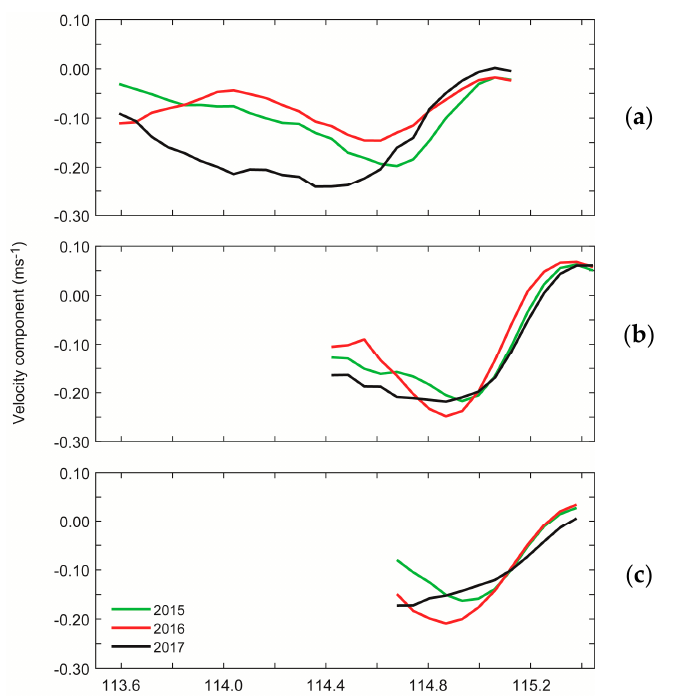
Figure 8. Mean cross-shelf profiles of HFR velocity for 2015, 2016 and 2017 at ( a ) 31° S; ( b ) 31.7° S; and, ( c ) 32° S. Units for the x -axis are °E.